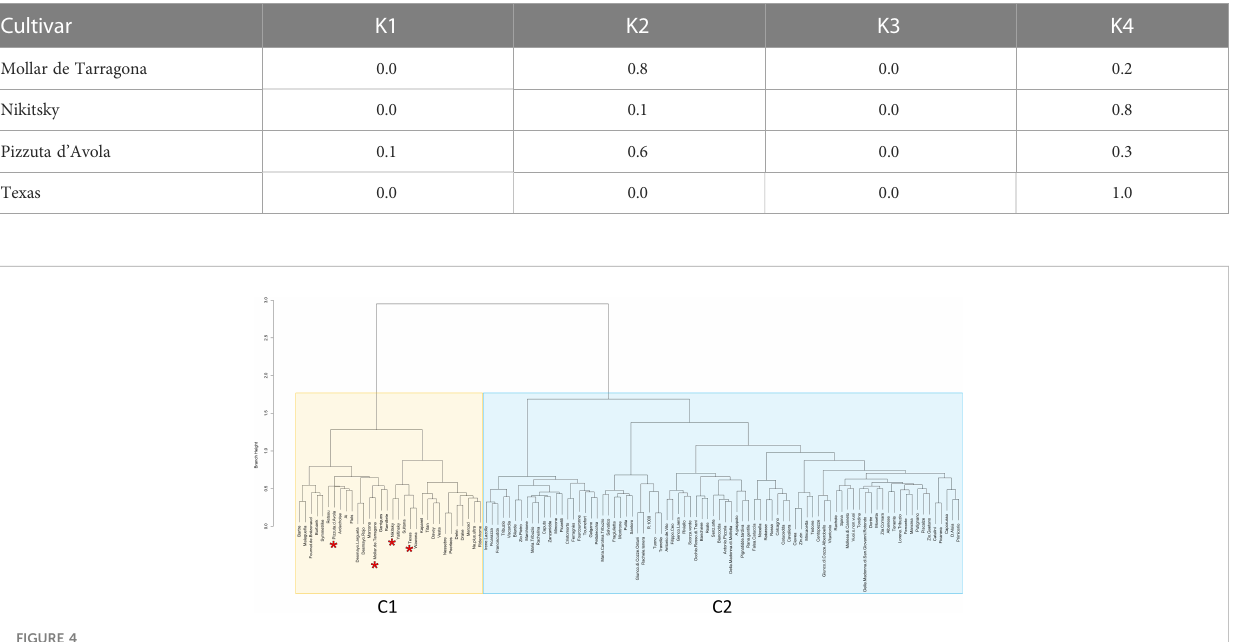
FIGURE 4 Results of hierarchical clustering with the AWclust algorithm. The two main clusters of the dendrogram (C1 and C2) are shaded with different colors. The names of the cultivars “ Mollar de Tarragona ” , “ Nikisky ” , “ Texas ” and “ Pizzuta D ’ Avola ” , harboring at least one copy of the Sk-2 allele, are highlighted with an asterisk.